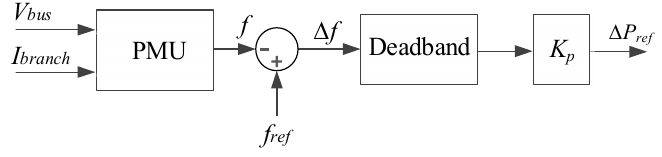
Figure 5. Schematic of the droop-based FAPR.